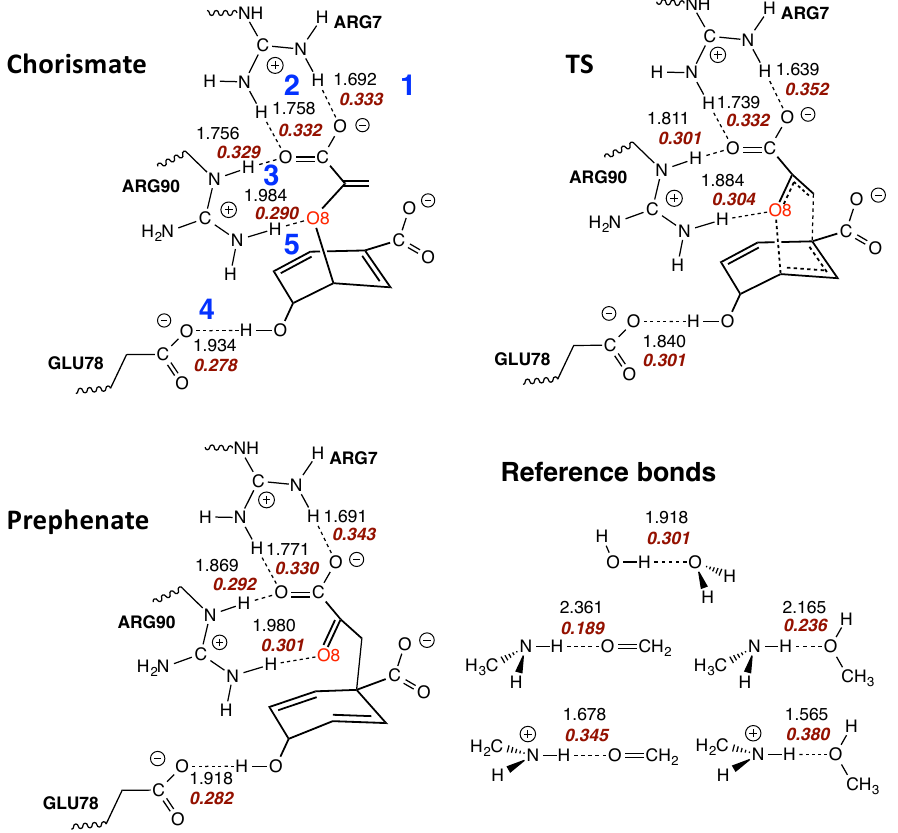
Figure 12. H-bond distances( in Ångstrom, black print ) and BSO n values (brown print) for the intermolecular hydrogen bonds in chorismate, the TS, and prephenate of reaction R5 and some reference molecules are shown. The five H-bonds established in the enzyme are numbered (blue print) in order to facilitate the discussion. (Reprinted with permission from [118]; copyright 2020 from Taylor and